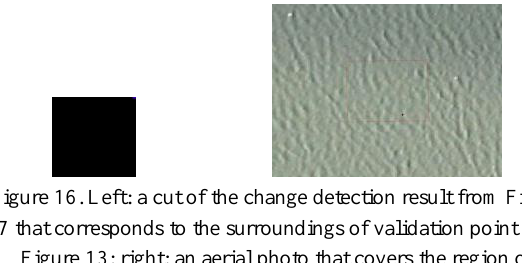
Figure 16. Left: a cut of the change detection result from Figure 7 that corresponds to the surroundings of validation point 3 in Figure 13; right: an aerial photo that covers the region of validation point 3.